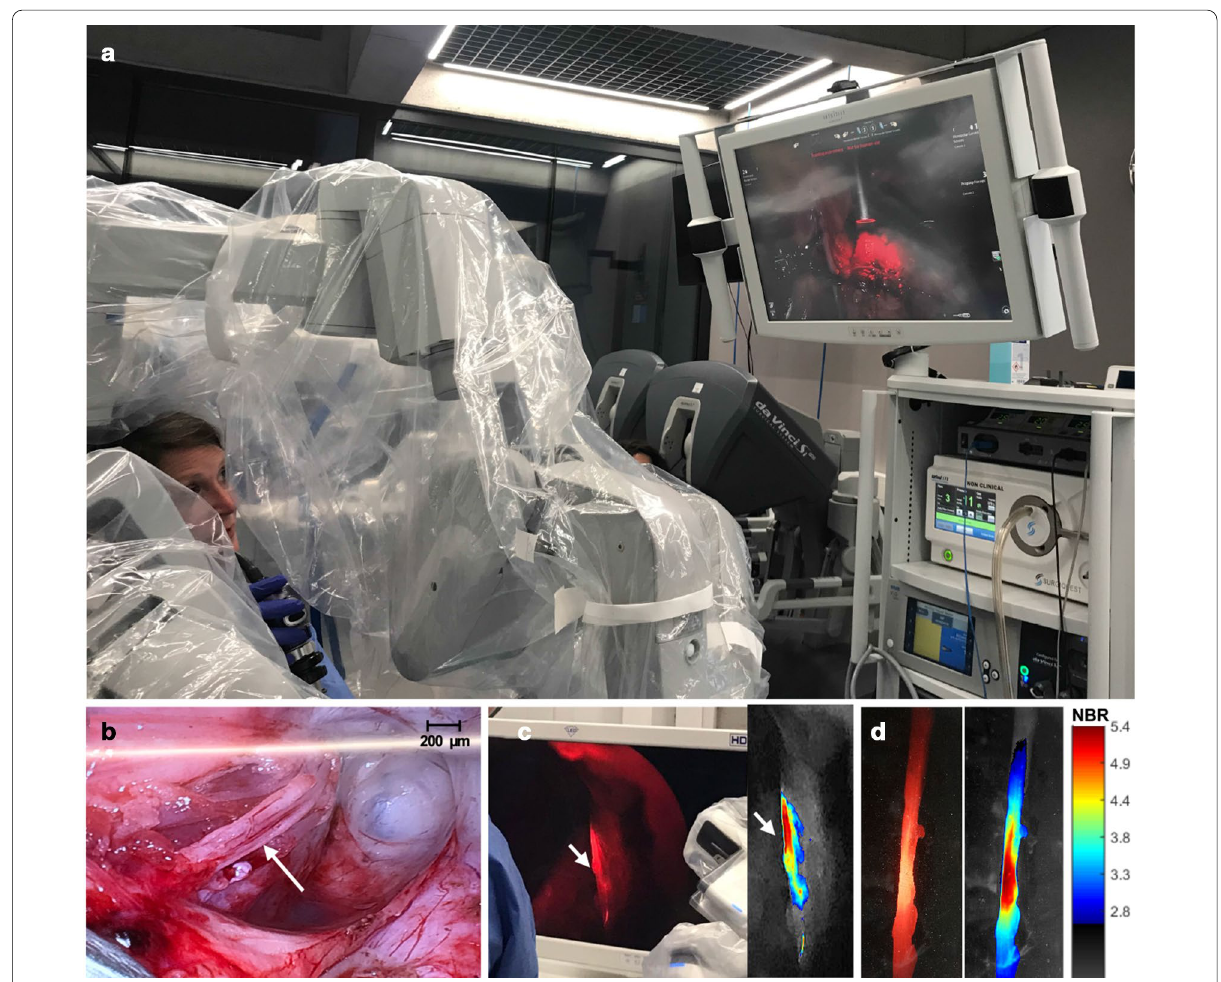
Fig. 6 Translation of Cy5-P0 101–125 into large animal models using clinical grade imaging modalities. A Surgical set-up showing the Da Vinci surgical robot and the use of a clinical grade STORZ fluorescence laparoscope dedicated for Cy5 imaging [42]. B Brightfield image of the pudendal nerve (white arrow). C In vivo fluorescence imaging of the pudendal nerve after intraneural administration of Cy5-P0 101–125 as visible on the screen of the imaging set-up. Insert showing a colour-coded processed image of the fluorescence in the nerve. D Ex vivo fluorescence image of the excised nerve (left image) with corresponding colour-coded image-processing (right image) and scale bar depicting the corresponding nerve-to-background ratio